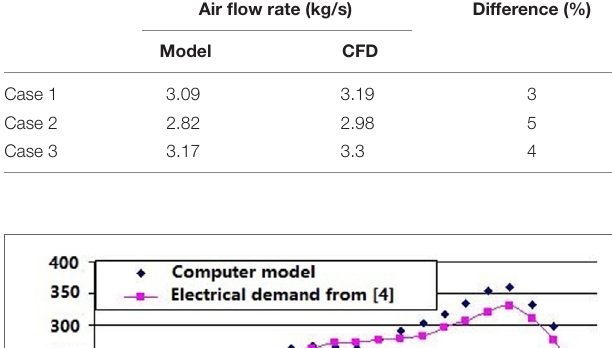
FigUre 4 | Predictions of the hourly thermal load, comparisons between computer model and esP-r program .